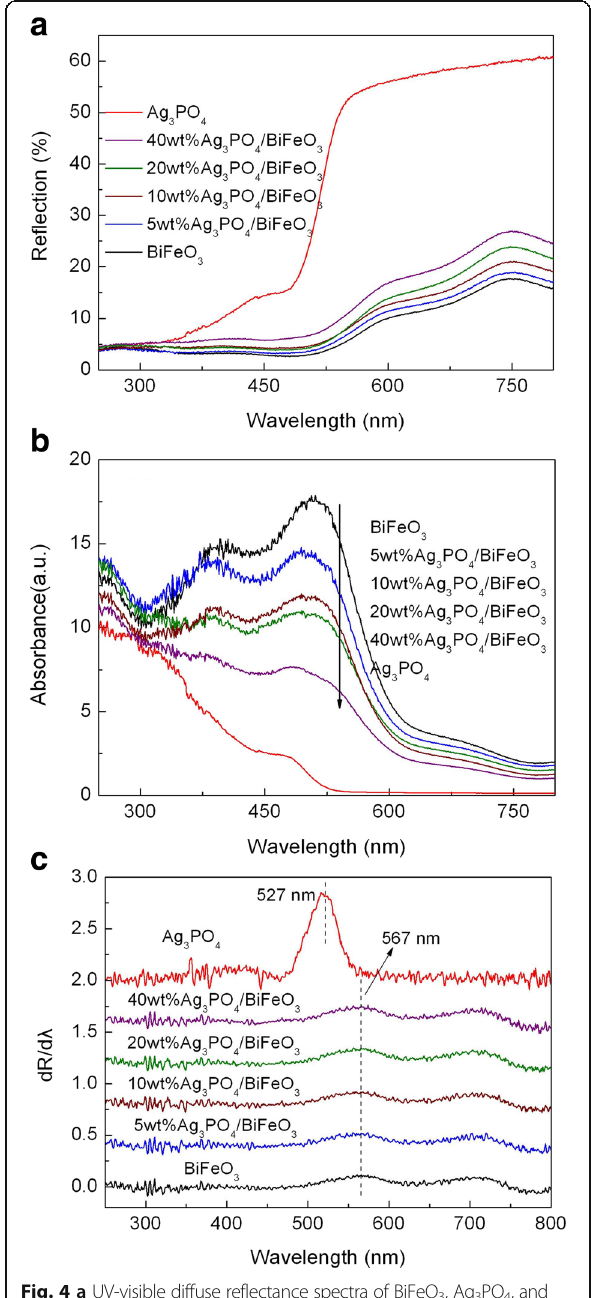
Fig. 4 a UV-visible diffuse reflectance spectra of BiFeO 3 , Ag 3 PO 4 , and Ag 3 PO 4 /BiFeO 3 composites. b The corresponding absorption spectra and c the corresponding first derivative of the diffuse reflectance